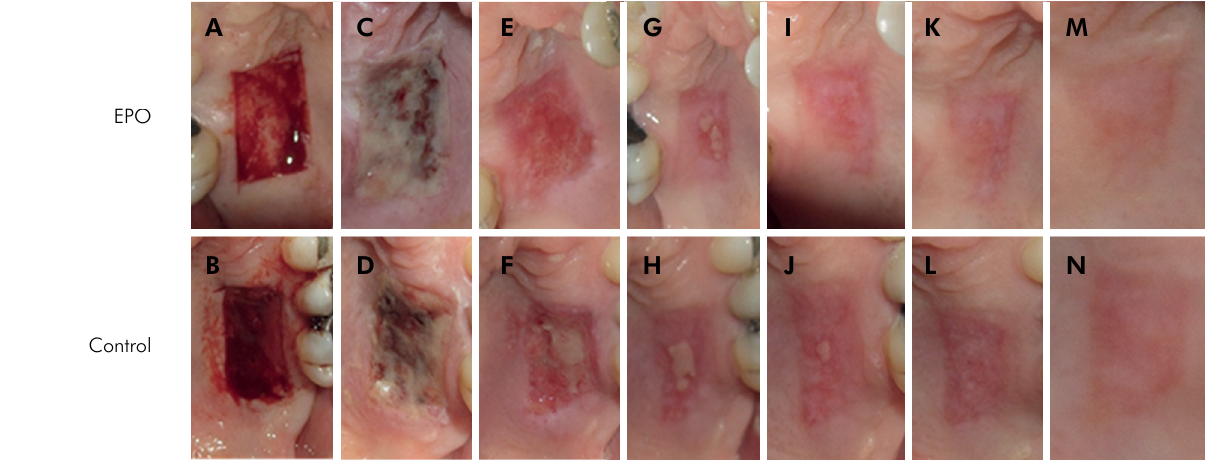
Figure 2. CONSORT statement flow diagram.